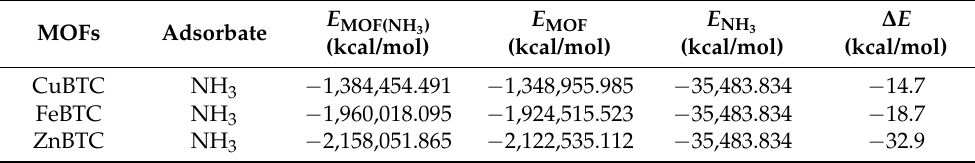
Table 1. The results of the theoretical calculation of Zn-BTC, FeBTC and CuBTC.